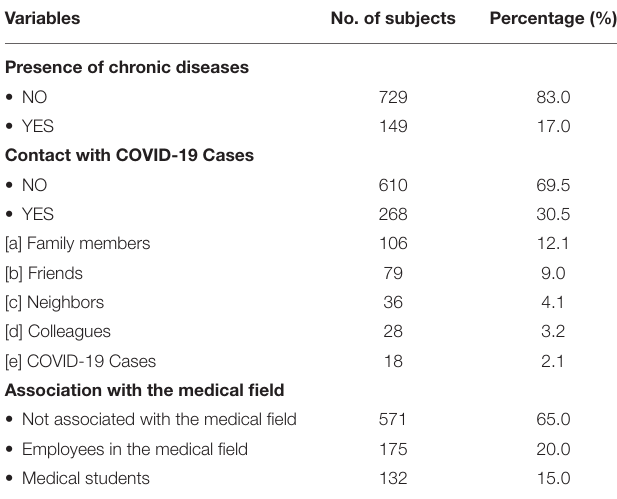
TABLE 1 | Socio-demographic characteristics of the study participants ( N = 878). Socio-demographic variables